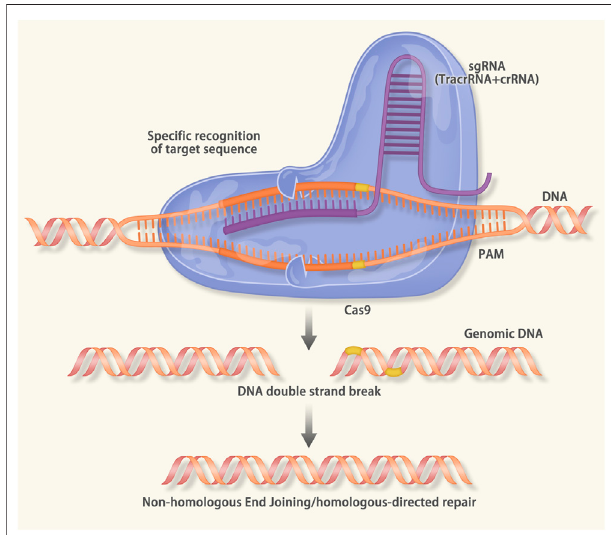
FIGURE 3 | Mechanism of the Clustered Regularly Interspaced Short Palindromic Repeats (CRISPR)/CRISPR associated protein 9 (Cas9): When viruses and foreign DNA invade the host, the cas1 and cas2 protein can recognize the protospacer adjacent motif (PAM) region. The cas1/2 protein will cut the PAM and insert it into the downstream of the leader sequence of CRISPR . When the same sequence invades the host, the transcription of precursor CRISPR RNA (pre-crRNA) and trans-activating crRNA(tracrRNA)willbeactivated.Thepre-crRNA,tracrRNAandthecas9will formacomplexthatcanrecognizethesequencethatiscomplementarytothe crRNA. After the recognition, the double-strand DNA unwinds to form an R-loop. The crRNA combines with the target sequence via base pairing. Then the double-strand-break (DSB) is induced by the cas9 protease. In the CRISPR/Cas9geneeditingtechnology,thesgRNAconsistingofthetracrRNA and thecrRNAisdesigned invitro .ThesgRNAwillguidethecas9toaspeci fi c DNA sequence to cause the DSB. After the DSB, endogenous DNA repairs systems (nonhomologous end joining in both dividing and nondividing cells, homology directed repair in the G2/S phase of dividing cells) result in the gene knock-in or knock-out.